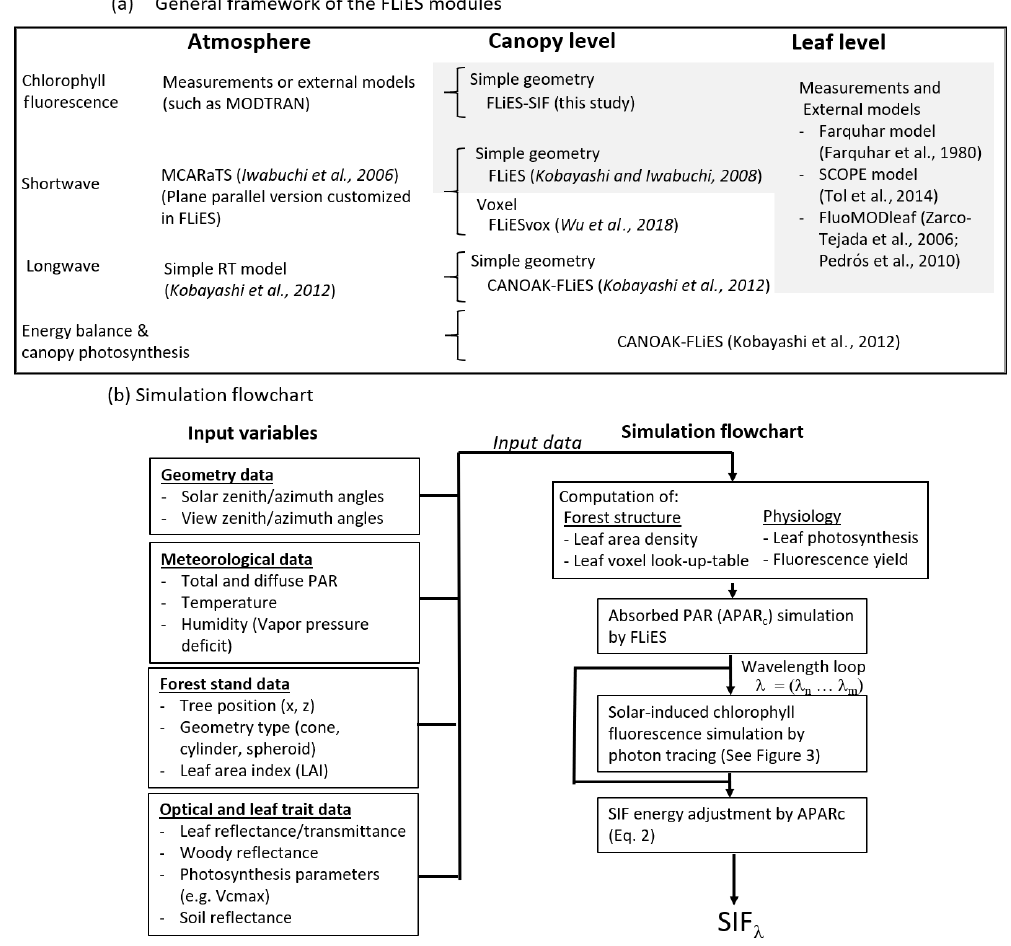
Figure 1. General outline of the FLiES modules and simulation flows. (a) General framework of the FLiES modules. Newly developed module in the current study is indicated by the grey-colored background. (b) Simulation flow and input data sets. Four major input data – geometry data, meteorological data, forest stand data, and optical and leaf trait data – are required to run the